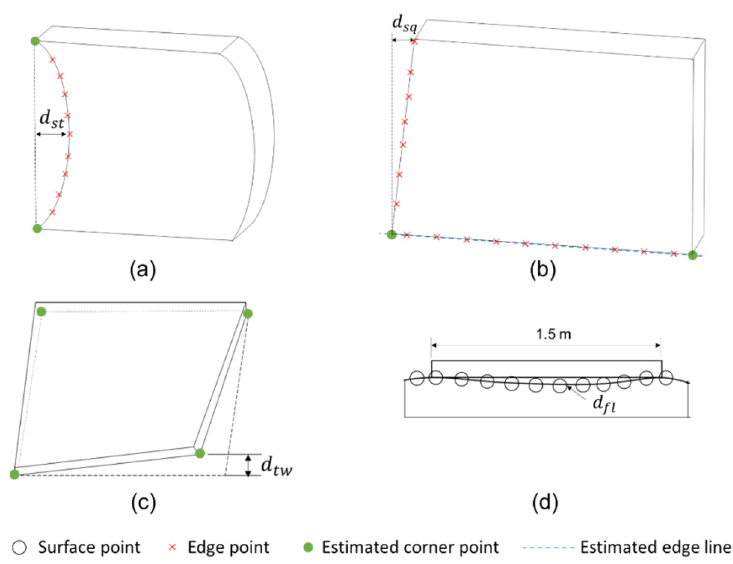
Figure 17. Surface quality inspection for structural elements: ( a ) straightness inspection, ( b ) squareness inspection, ( c ) twist inspection, and ( d ) flatness inspection.